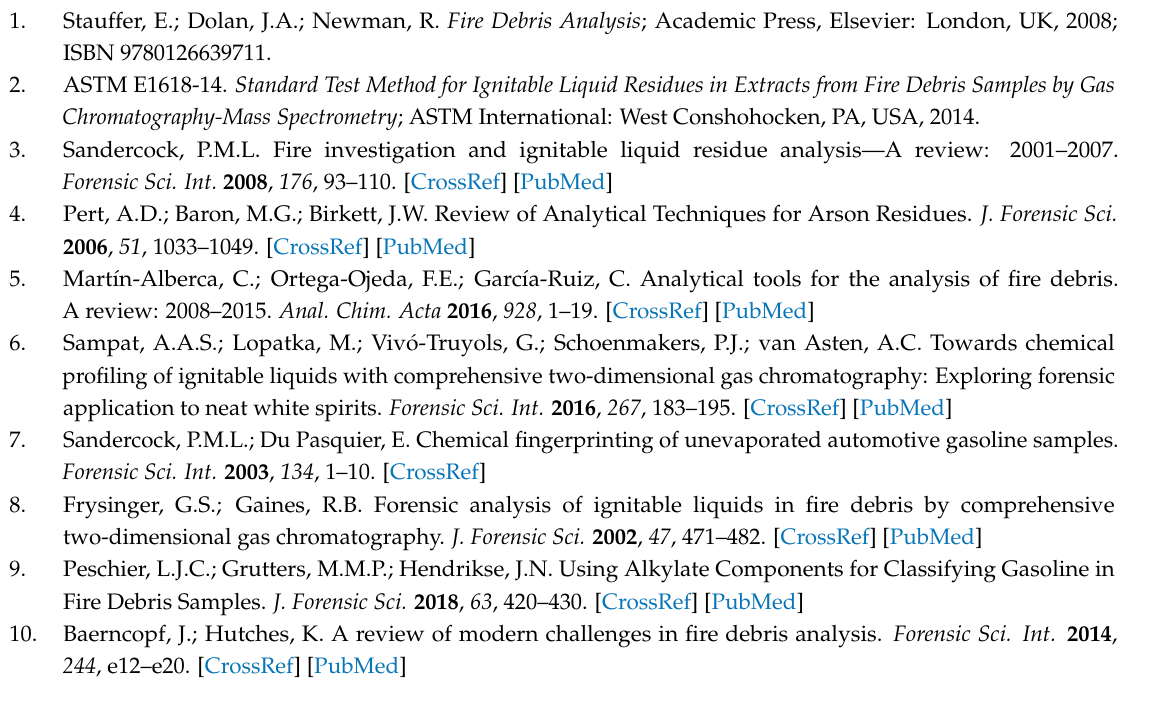
Figure S3: IL_Lamp oil, Figure S4: Single substrates, Figure S5: Substrate mixtures, Figure S6: Substrate mixtures with IL, Table S1: Details of ILs, Table S2: Typical compounds in ILs, Table S3: Compounds identified in substrates, Video S1: Fire